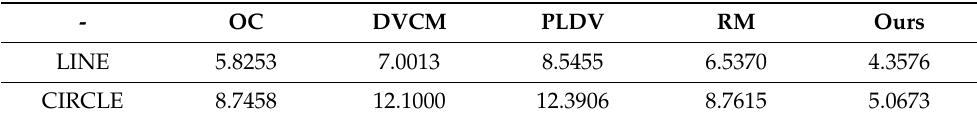
Table 2. SMEs of five algorithms for LINE and CIRCLE patterns (variance